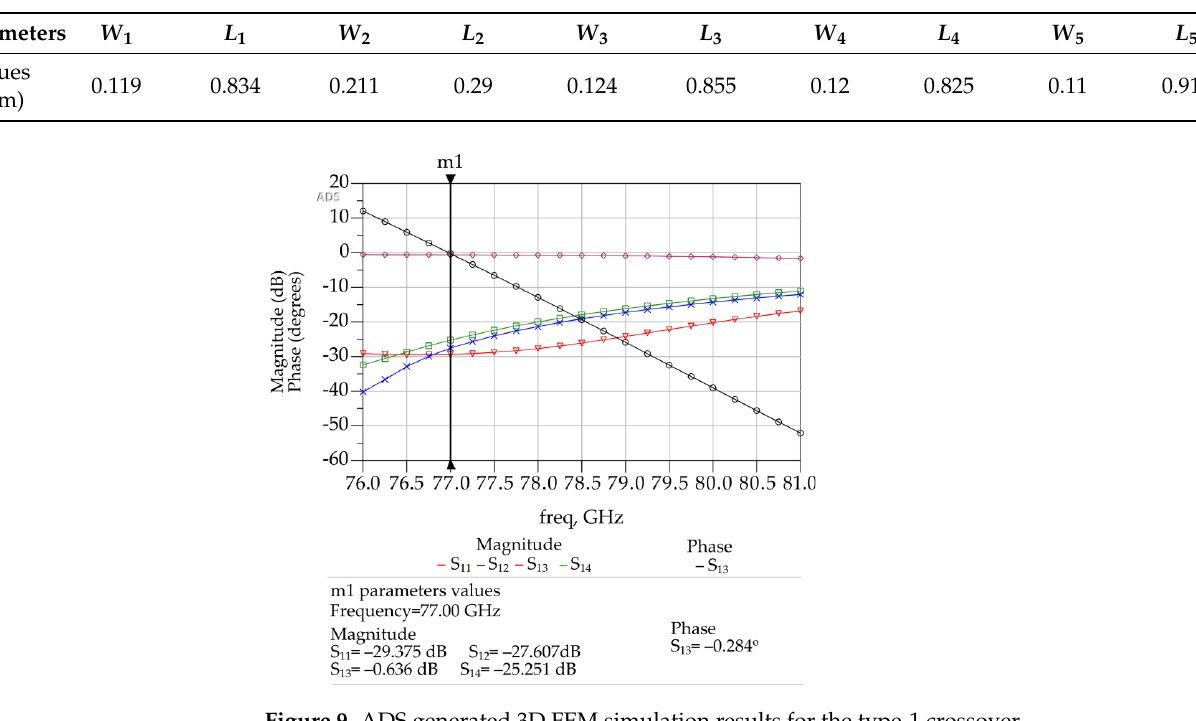
Table 5. Optimized dimensions of the type-1 crossover. Figure 8. Layout of the type-1 crossover in ADS.